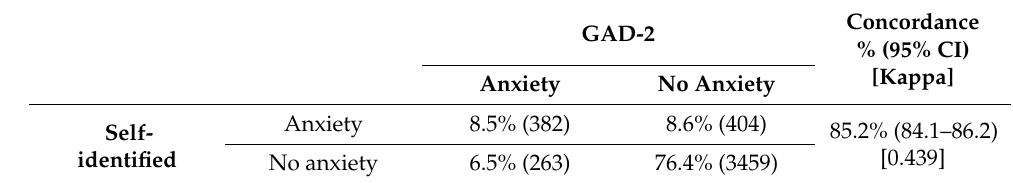
Table 2. Concordance and kappa values for self-identified anxiety and GAD-2 (n = 4508).